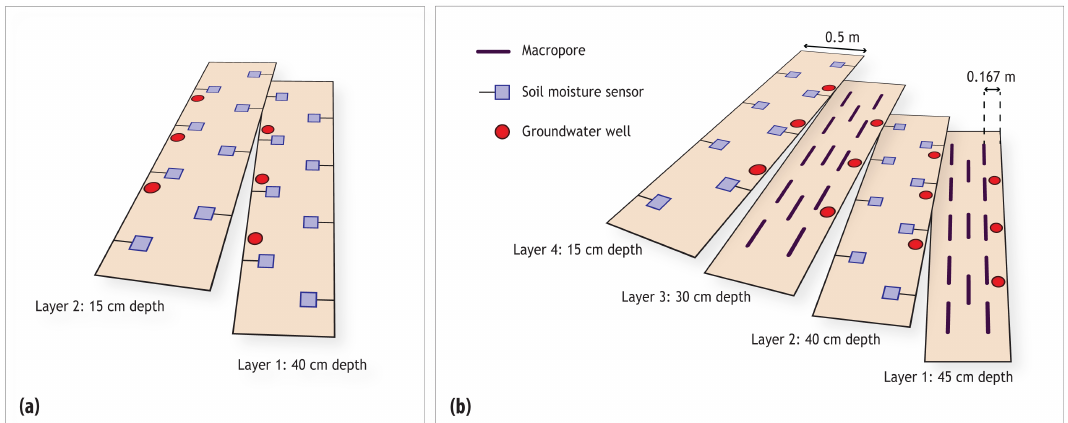
Figure 7. Schematic drawing of the layers of soil moisture sensors and macropores inside hillslope 1 ( a ) and hillslope 2 ( b ). Note the resemblance between the layers with soil moisture sensors for both hillslopes, and the only differences are the two extra layers of horizontal macropores that are added to hillslope 2.